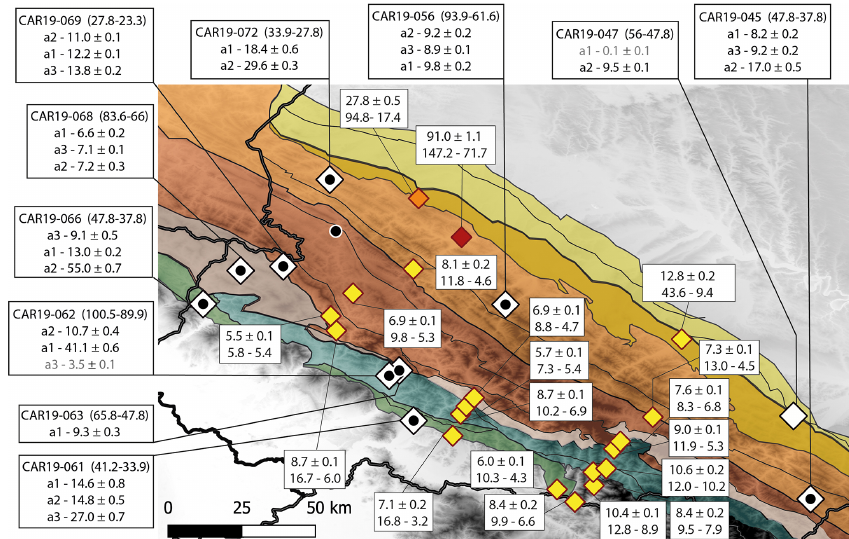
Figure 4. Apatite (U–Th) / He ages in the Ukrainian Carpathians. The symbols and color scale for the data are as indicated in Fig. 3. Single- grain ages, corrected for α ejection, from this study are detailed next to the map frame (numbers in parentheses next to sample code denote the depositional age range). Previously published data (Andreucci et al., 2013, 2015; Merten et al., 2010) are reported on the map as the average age and associated uncertainty, with maximum and minimum single-grain ages below. Ages in grey are interpreted to be outliers and are not used in the models or in our interpretations.